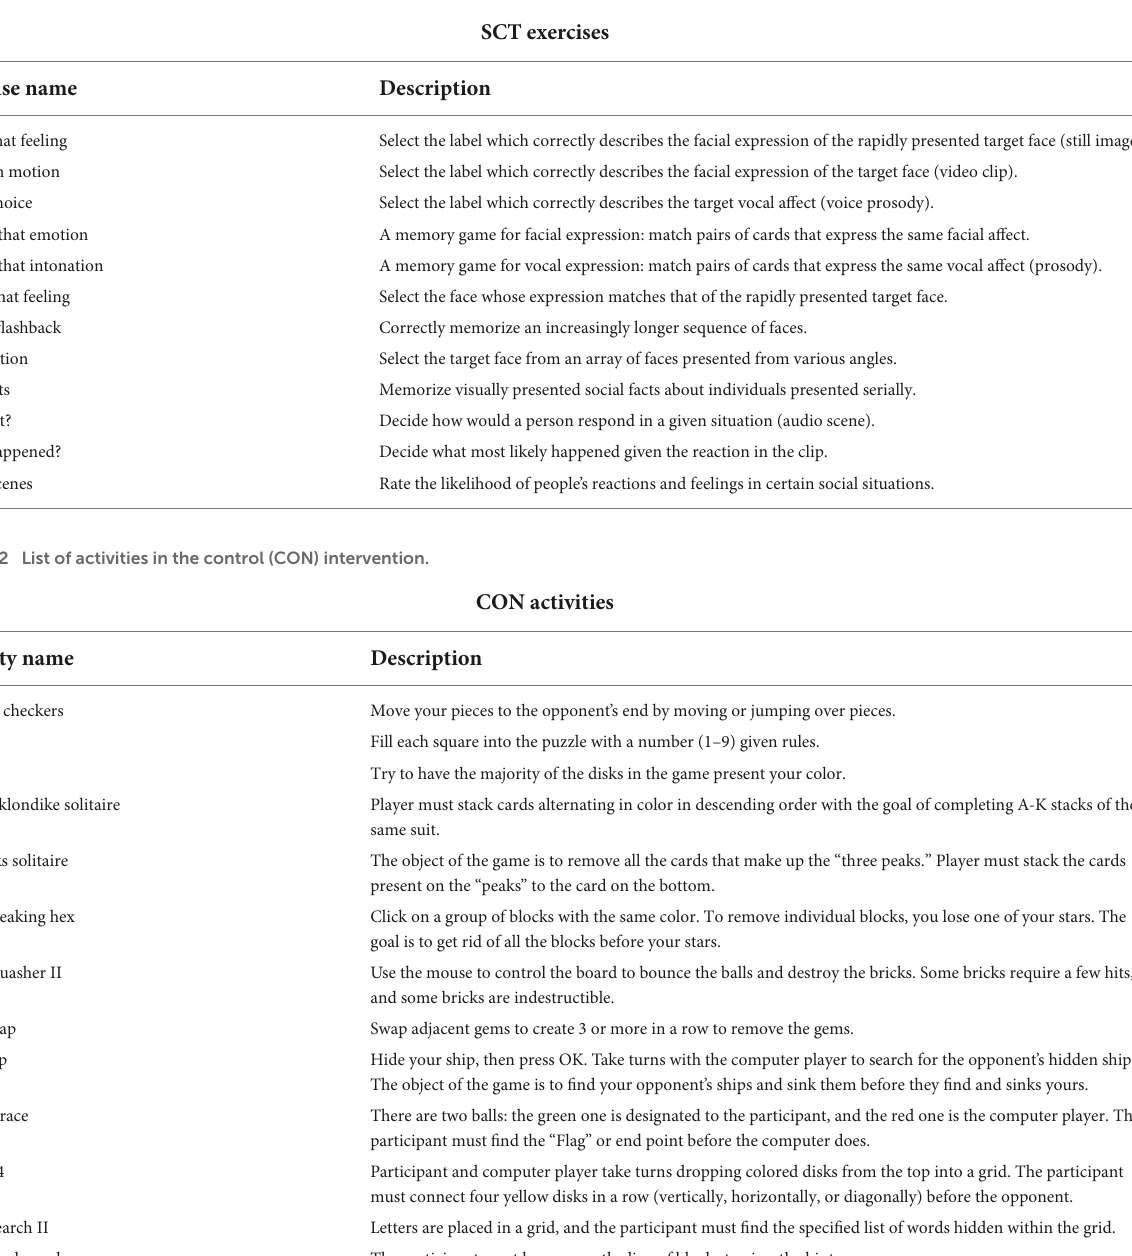
TABLE 1 List of exercises in the social cognition training (SCT) intervention.